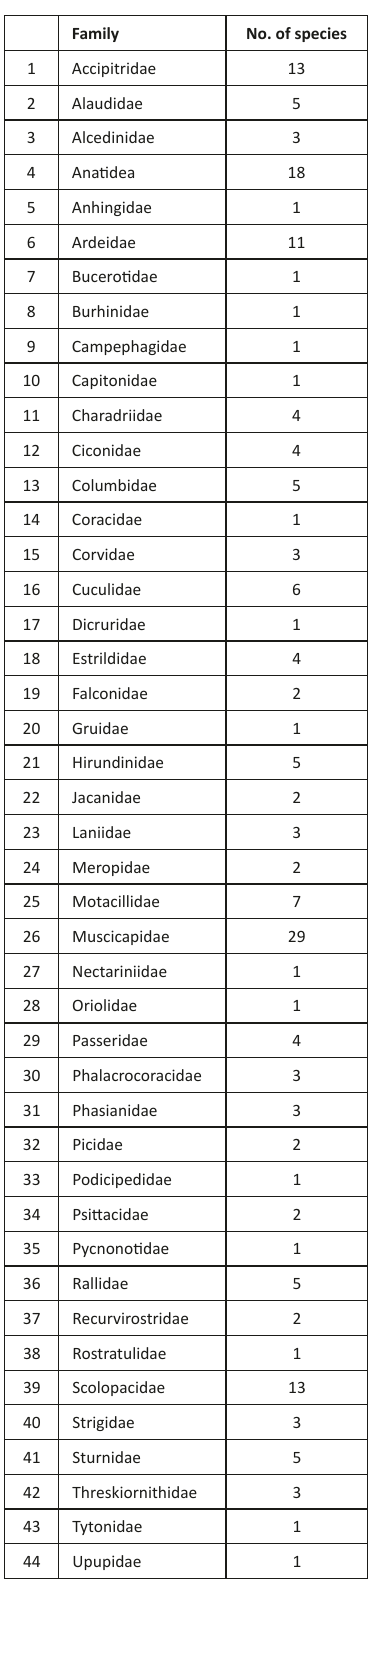
Table 1. Status of bird families